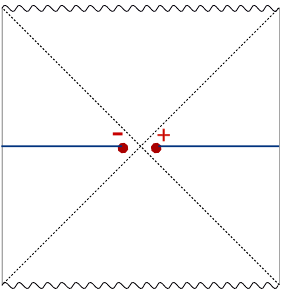
Figure 7: Construction of the Wilson line via OPE fusion at the bifurcation surface of a nega- tively charged operator from the left and a positively charged operator from the